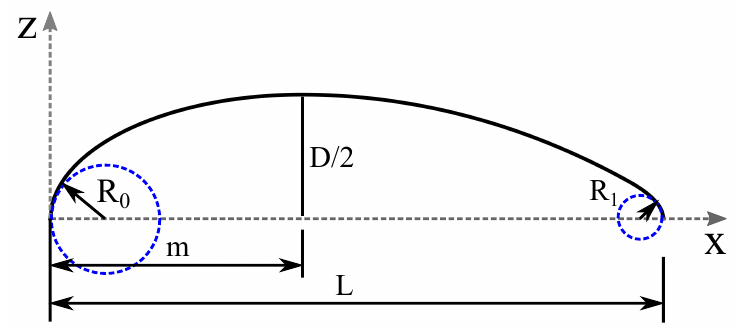
Figure 8. Design variables (geometric parameters) of the Gertler-58 Shape Generator.